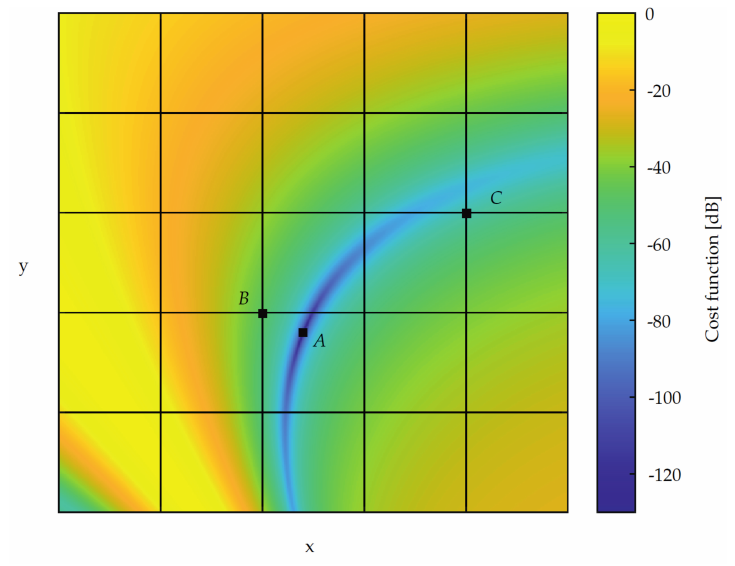
Figure A1. Exemplary cost function. The sensor is located at point A . Due to the relatively coarse grid (black lines), there will be a localization error of at least the distance between the point B and point A . However, due to the shape of the cost function, the minimum that is crossing the grid lines—and thus the localization outcome—is at point C